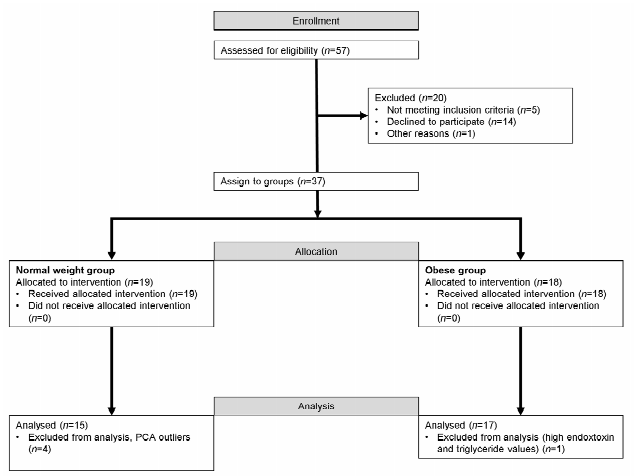
Figure 1. Participating flow chart.